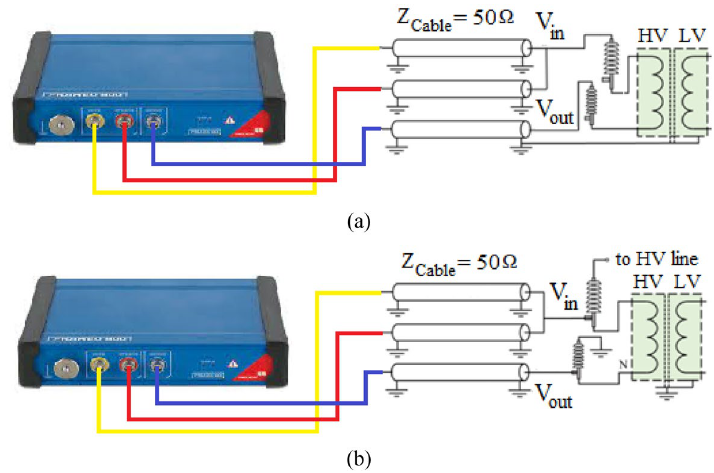
Figure 1. the setup of FRA measurement: ( a ) off-line; ( b ) on-line